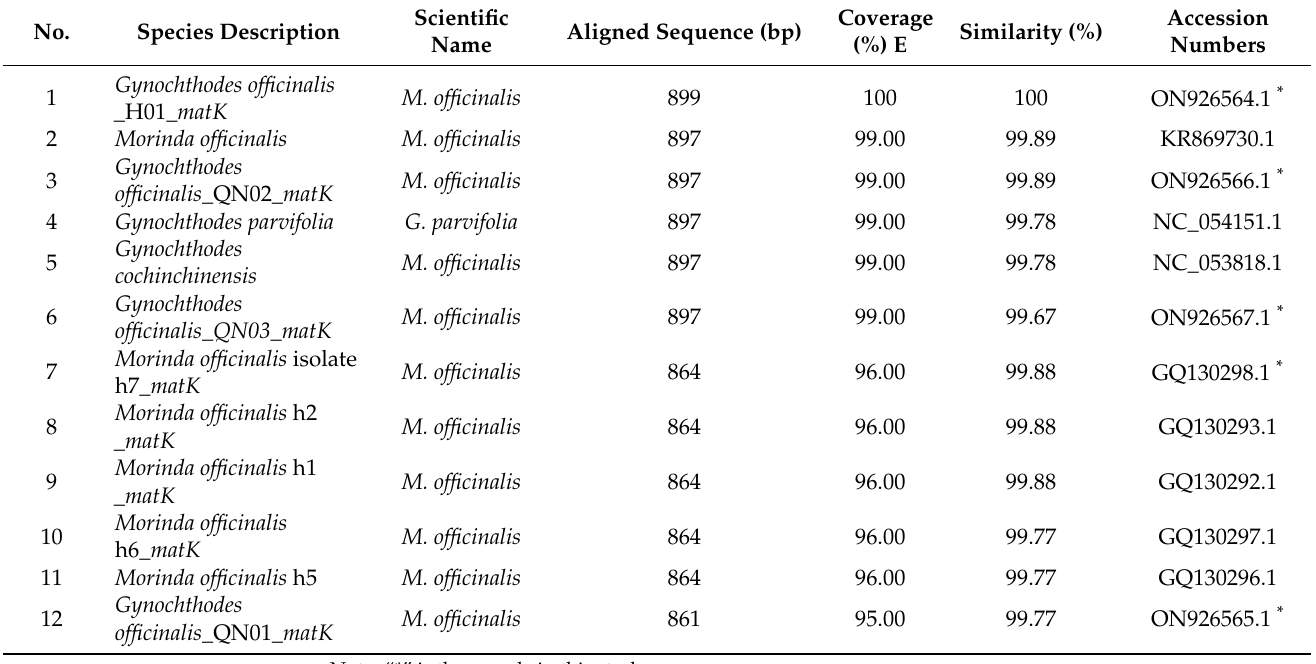
Table 5. M. officinalis plants in this study and the percentage of similarity with the closest species in the GenBank as per matK gene sequences.